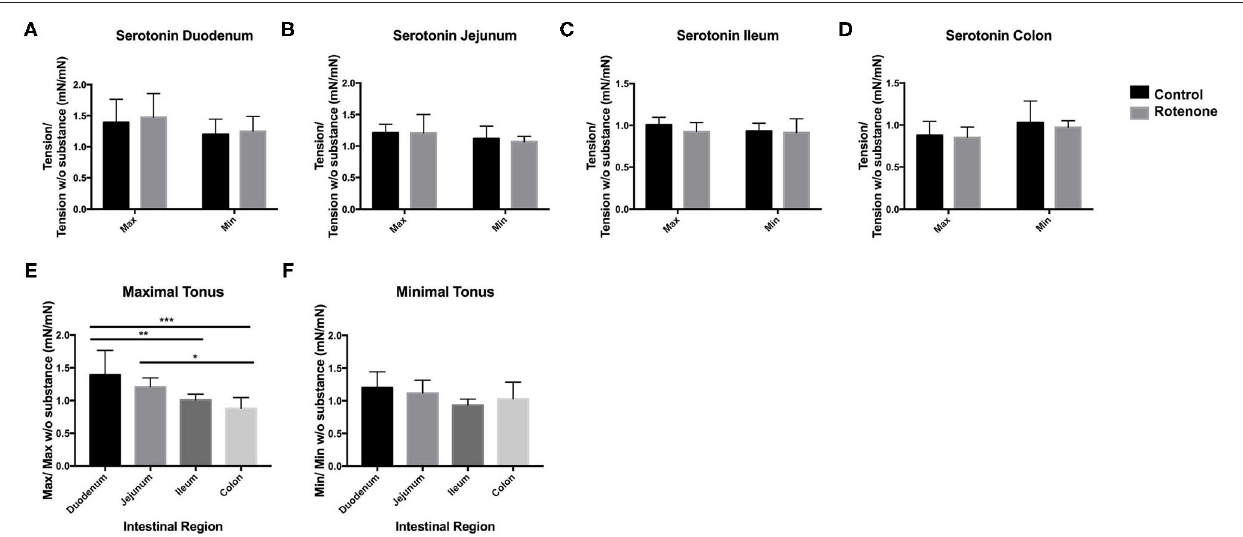
FIGURE 8 | Effect of serotonin (S) on the maximal contractility force and the tone on all intestinal regions. (A–D) Bar graphs showing the effect of serotonin on the duodenum (A) , jejunum (B) , ileum (C) , and colon (D) of control (black) and rotenone-exposed (gray) mice. Bar graph in (E) shows a comparison of the maximal contractility force exerted by serotonin between intestinal regions in control mice. Bar graph in (F) shows a comparison of the effect of serotonin on the tone between intestinal regions in control mice. Data was analyzed using a Student’s t -test. *, **, *** correspond to P < 0.05, P < 0.01, and P < 0.001, respectively. Error bars represent SEM in all graphics.